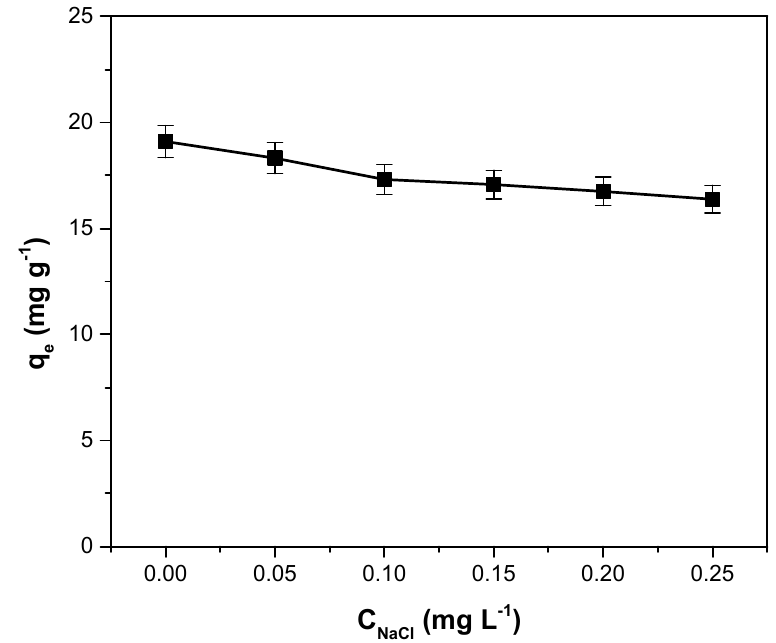
Figure 8. The influence of the ionic strength on adsorption capacity for crystal violet adsorption on adsorbents obtained from motherwort biomass.